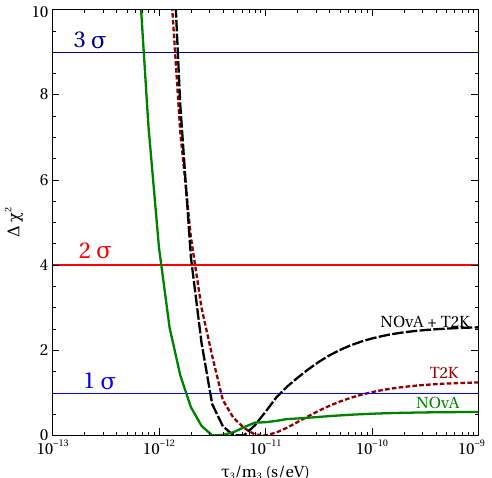
Figure 1 . (cid:1) (cid:31) 2 = (cid:31) 2 (cid:0) (cid:31) 2 vs. (cid:28) 3 =m 3 obtained from the analysis of T2K data (red dashed line), min NOvA data (solid green line) and T2K+NOvA data (black long dashed